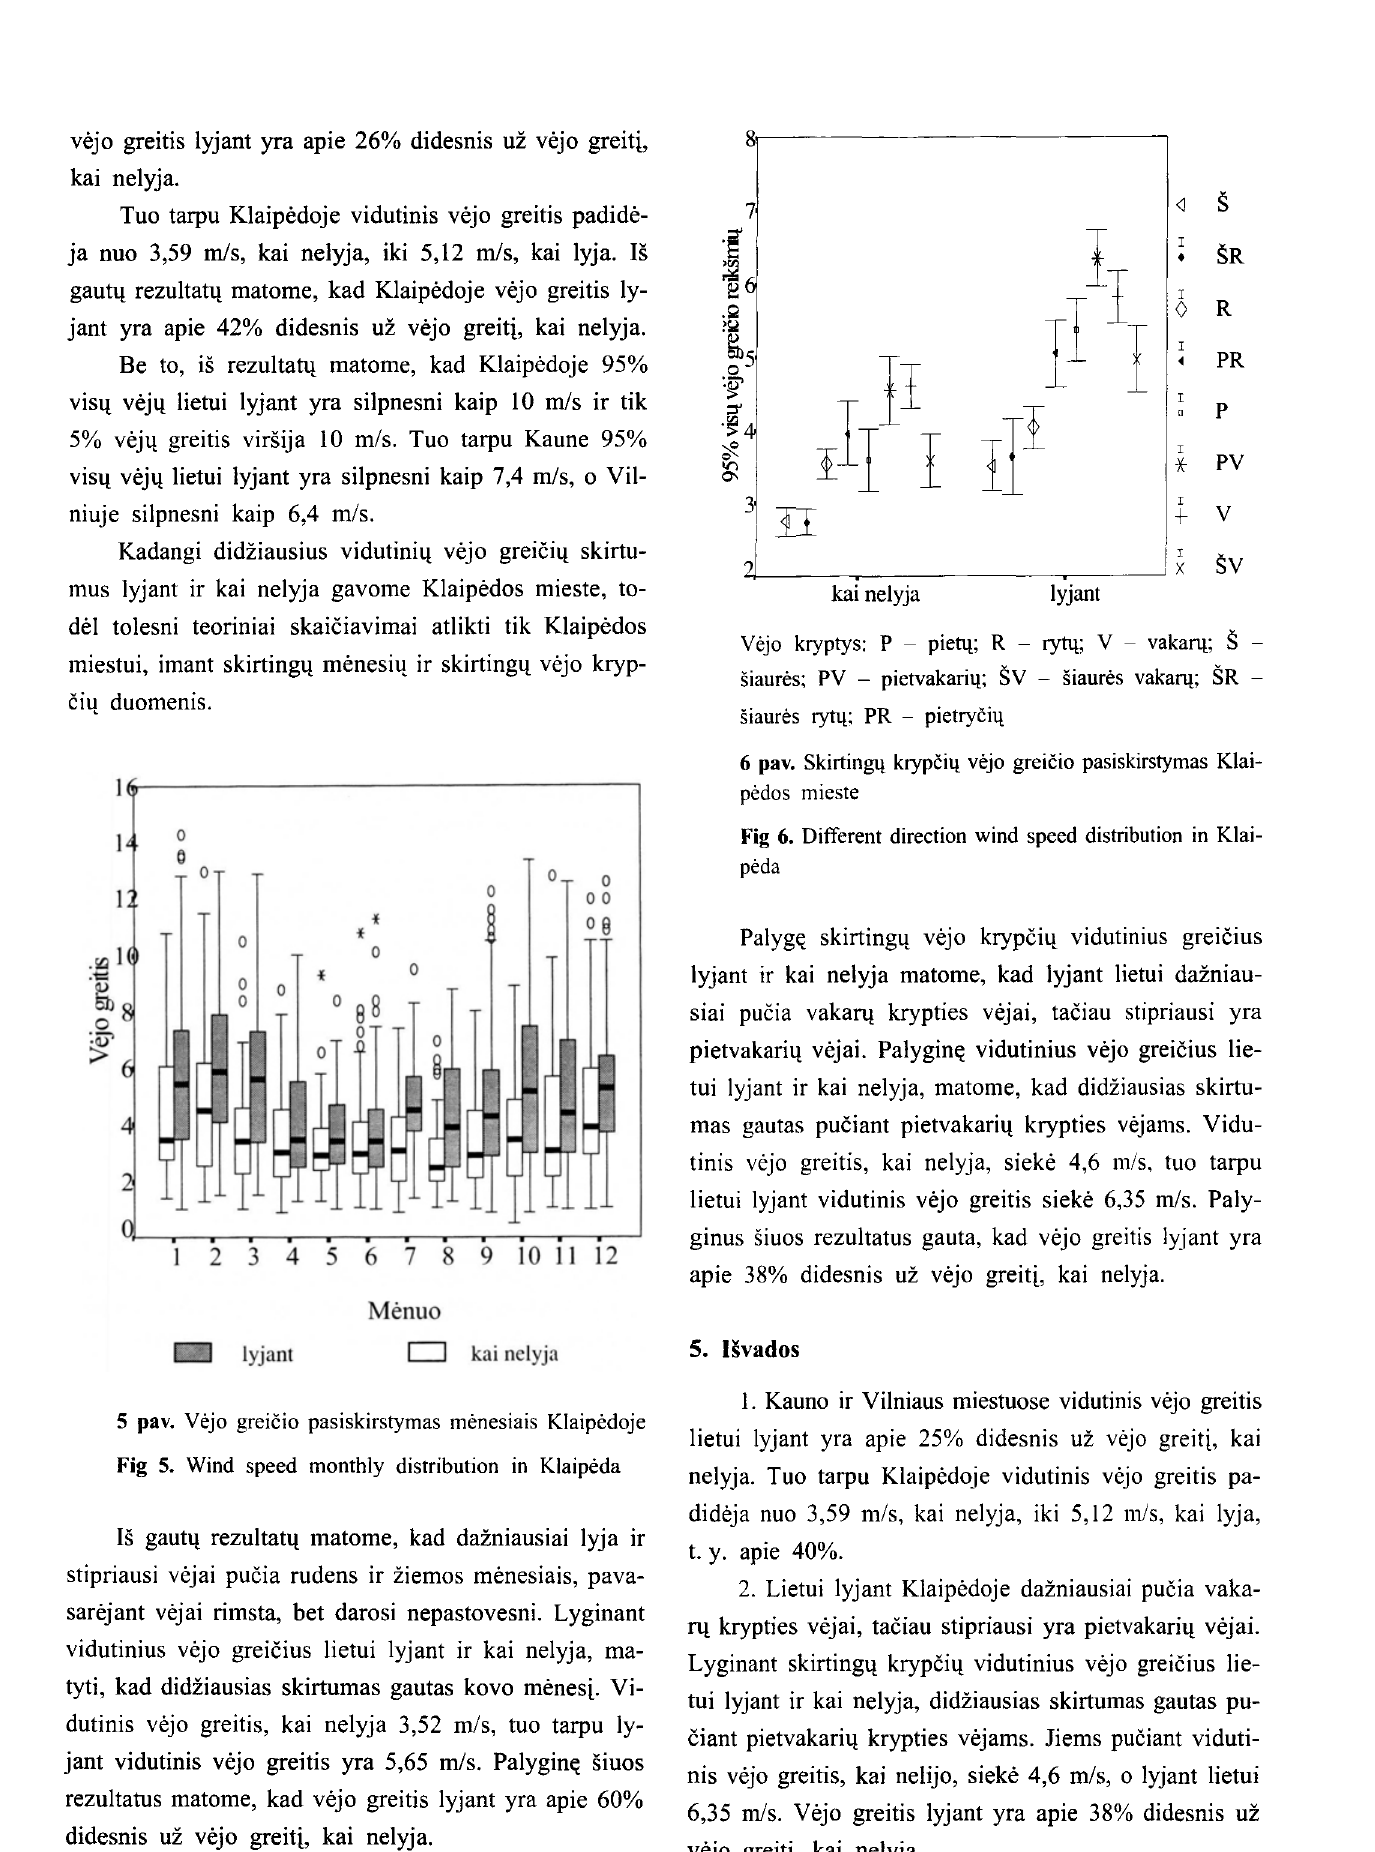
Fig 5. Wind speed monthly distribution in Klaipeda IS gautq rezultatq matome, kad dazniausiai lyja ir stipriausi vejai puCia rudens ir ziemos menesiais, pava sarejant vejai rimsta, bet darosi nepastovesni. Lyginant vidutinius vejo greicius lietui lyjant ir kai nelyja, ma tyti, kad didziausias skirtumas gautas kovo menesi. Vi dutinis vejo greitis, kai nelyja 3,52 m/s, tuo tarpu ly jant vidutinis vejo greitis yra 5,65 m/s. Palygine; siuos rezultatus matome, kad vejo greitis lyjant yra apie 60% didesnis uz vejo greiti, kai nelyja.